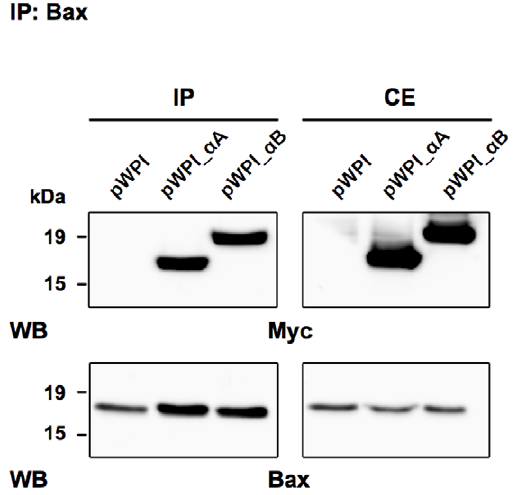
Figure 2. Interaction of a -crystallins with Bax invivo . 293T cells transiently transfected with the empty vector (pWPI), myc-tagged a A- (pWPI_aA) or a B- (pWPI_aB) crystallin were further treated with 100 nM STS for 3 h before co-immunoprecipitation with anti-Bax antibody. The precipitated samples were then sequentially probed by western blot using anti-myc and anti-Bax antibodies. IP: immunoprecipitated samples ( left panels ); CE: 20 m g of total proteins from whole cell extract ( right panels